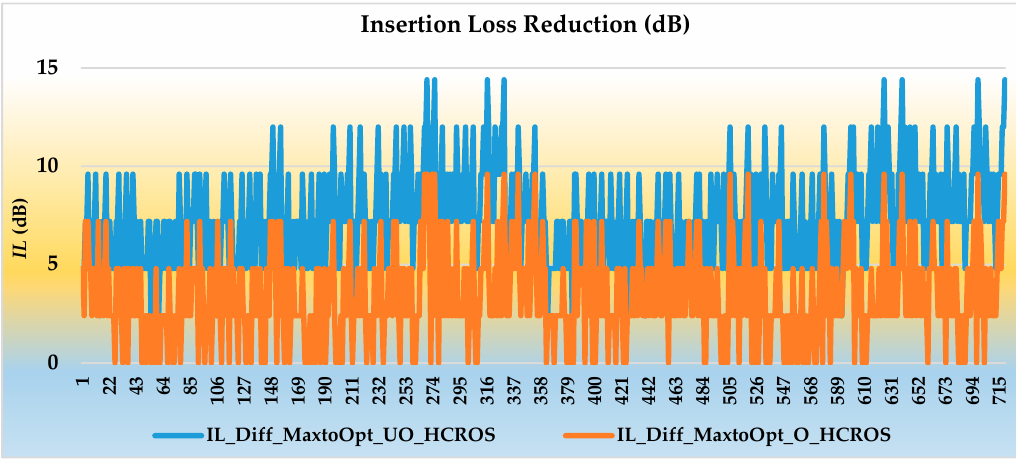
Figure 21. Insertion loss reduction in un-optimized and optimized HCROS for all 720 I/O links. Table 13. Maximum / minimum power consumption with power saving and maximum / minimum insertion loss with reduction for 720 I / O